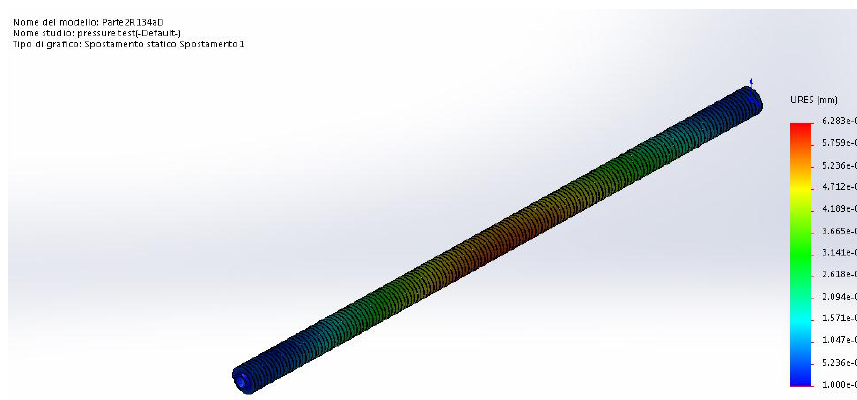
Figure 16. Diagram of resulting displacement.